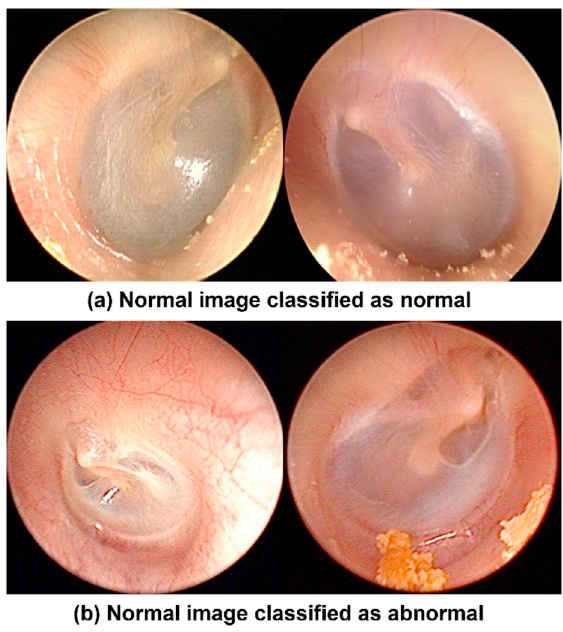
Figure 12. Example of misclassified images.